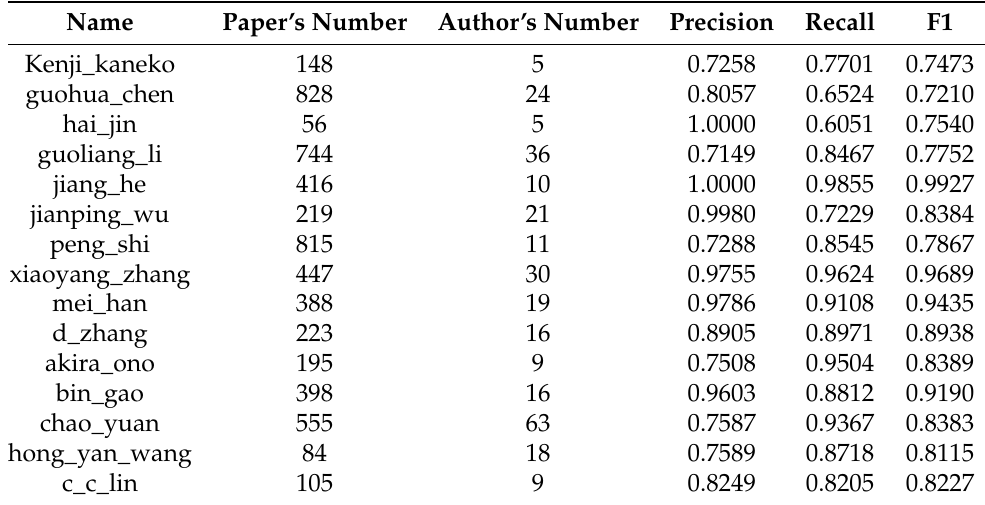
Table 8. Name disambiguation